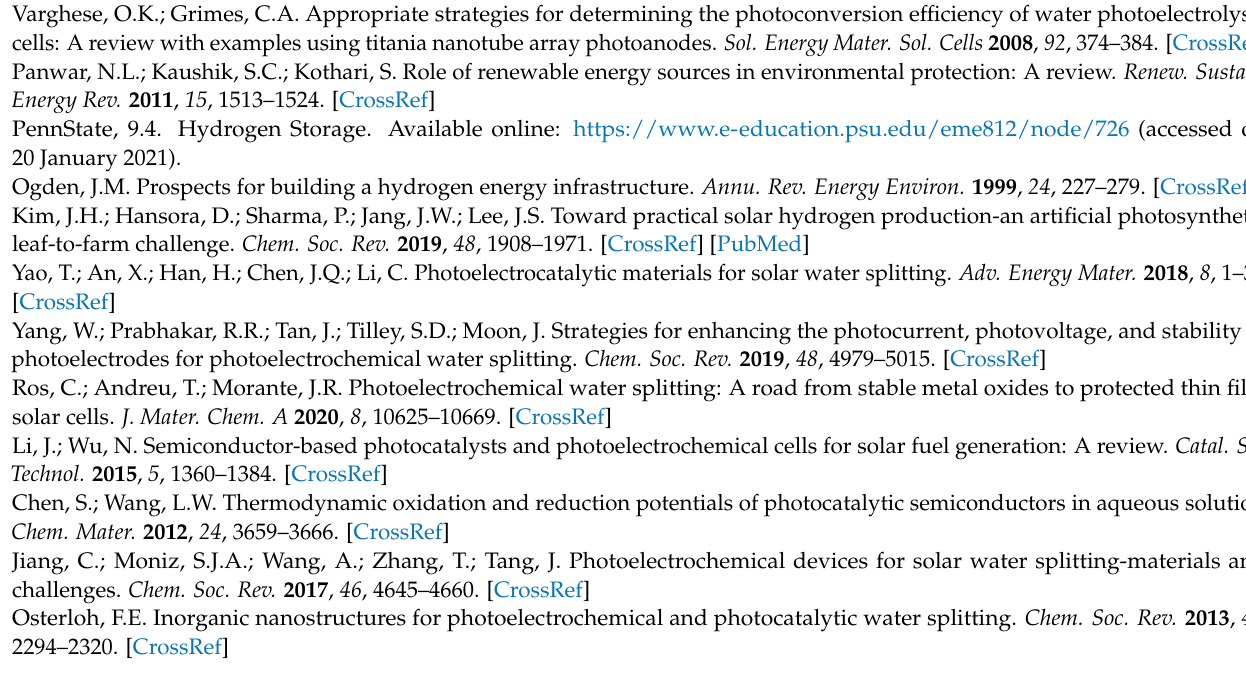
Table S1: Electrical characteristics of the various ZnO thicknesses on CNT/silicon; Figure S4: Nyquist diagram of CNT-ZnO samples under dark and light conditions at 1.23 VRHE with a fitting electric circuit model parameter; Table S2: Electrical characteristics of the various ZnO thicknesses on silicon; Figure S5: Photocurrent stability for CNT-ZnO and Si-ZnO samples was measured in 0.1M NaOH solution (pH 12.7 (left) and in borate solution (right), under 1 sun illumination and a bias of 1.23 VRHE. The